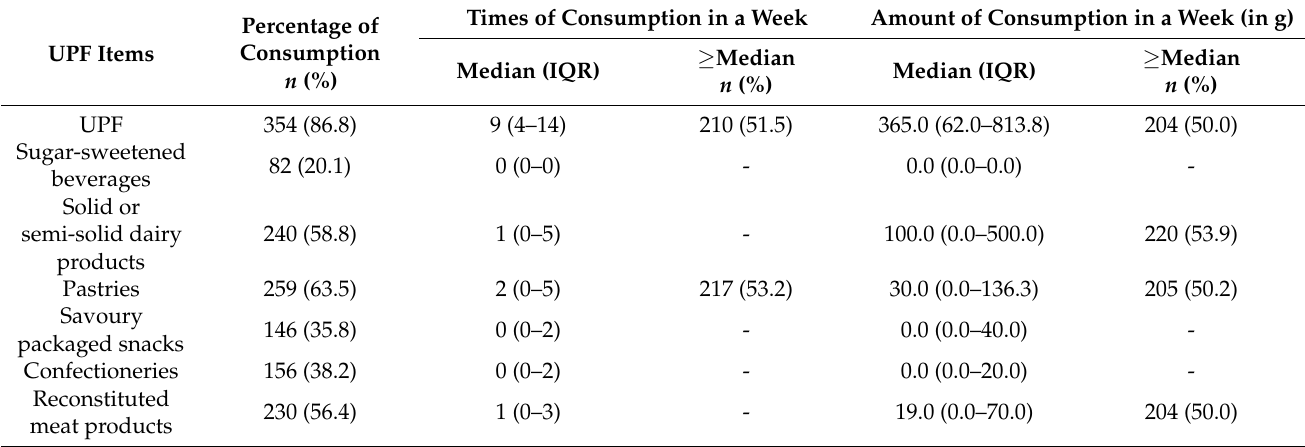
Table 2. Children’s consumption of UPF ( n =